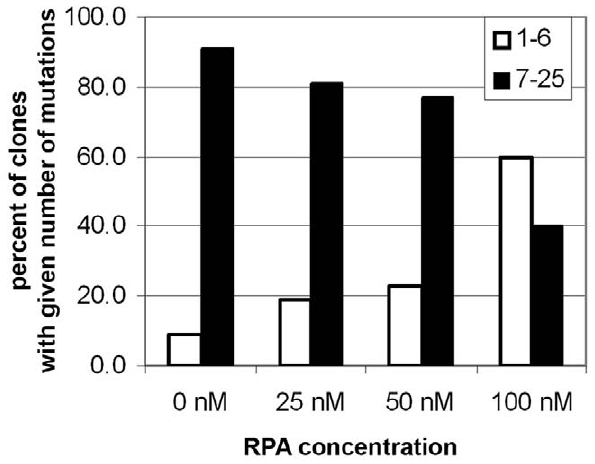
Figure 7. RPA inhibits A3G processivity invitro . Proportions of ura3 mutant clones with less (white bars) and more (black bars) than seven substitutions in the ORF are shown as a function of hRPA concentration. The observed differences between frequencies of clones with multiple mutations obtained in different experimental conditions are significant (P=0.002 according to the x 2 test).